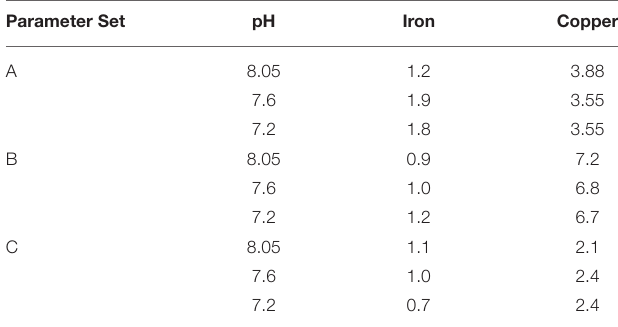
well with that obtained from the real titrations. Correlation